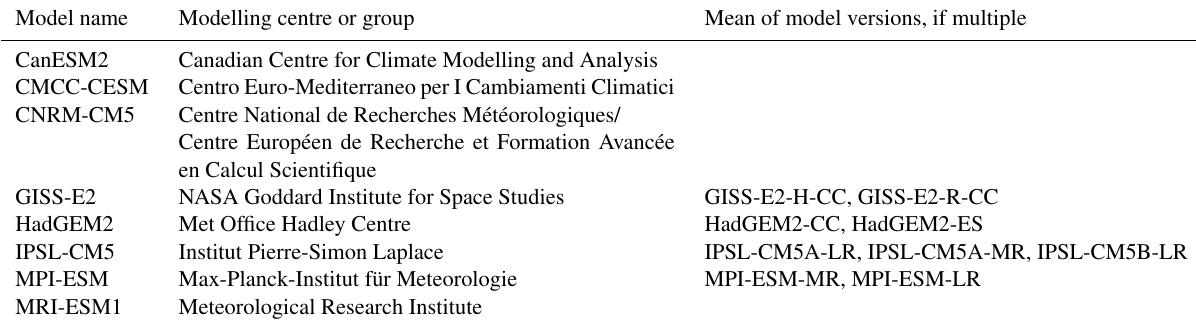
Table B1. List of CMIP5 models containing sea surface chlorophyll concentration data used for the “CMIP5chl” simulation. Model